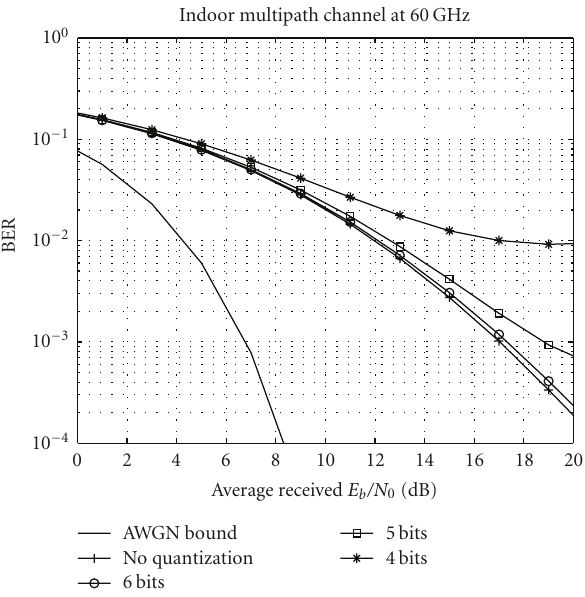
Figure 14: Impact of quantization on the BER performance of OQPSK.